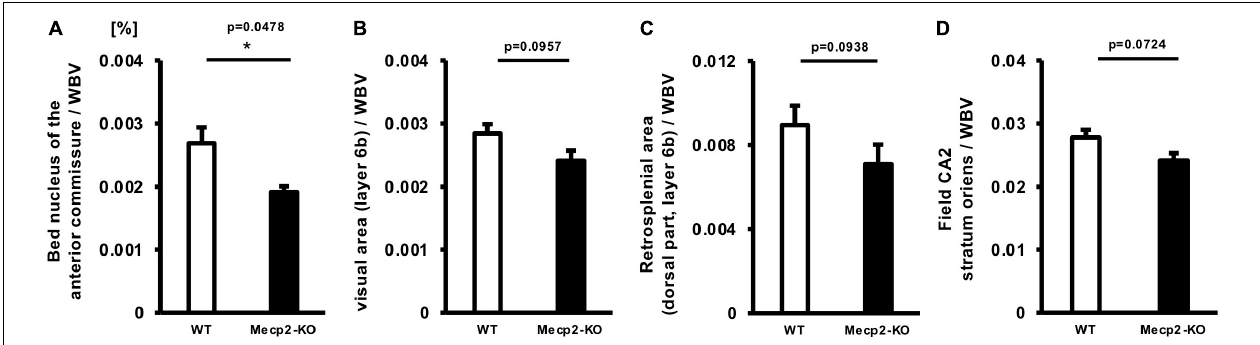
FIGURE 4 | Comparison between normalized brain region volumes of WT and Mecp2 -KO mice obtained using detailed volume-based morphometry. The ratio of each regional brain volume to the whole-brain volume was evaluated and specific regional changes, such as the bed nucleus of the anterior commissure (A) , posteromedial visual area (layer 6b) (B) , retrosplenial area (C) , and field CA2 stratum oriens (D) of Mecp2 -KO mice were detected. Statistical test: Welch’s t -test. n = 4 mice per group. *Significant difference.